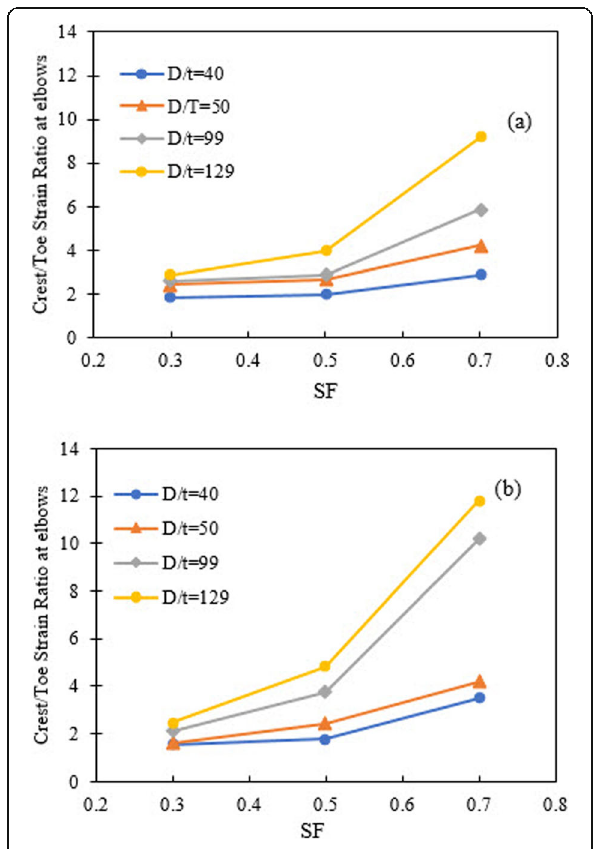
Fig. 15 Effect of D/t and SF on the maximum strain ratio of pipeline elbows at the crest and toe of the slope: ( a ) Chi-Chi earthquake; ( b ) Northridge